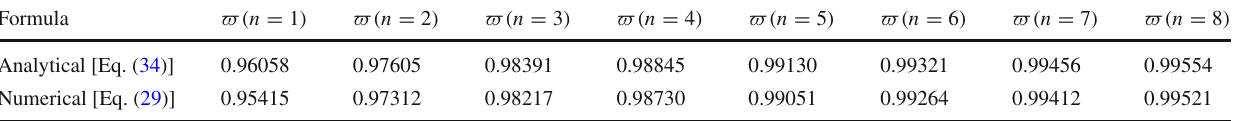
frequencies (cid:16) numerical ( n ; α,γ,(cid:14)) of the stationary composed star–field configurations.Inthephysicalregime(31)ofmarginally-boundmassive scalar field configurations, one finds a remarkably good agreement (see footnote 15) between the exact resonant field frequencies [as obtained numerically from the characteristic resonance condition (29)] and the correspondinganalyticallyderivedresonantoscillationfrequencies(34) which characterize the stationary bound-state star–field